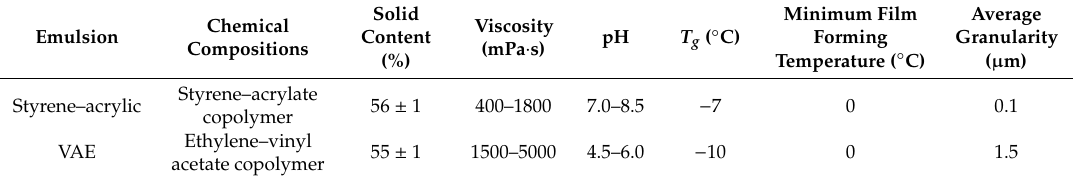
Table 1. Chemical compositions and physical properties of styrene–acrylic and VAE emulsion